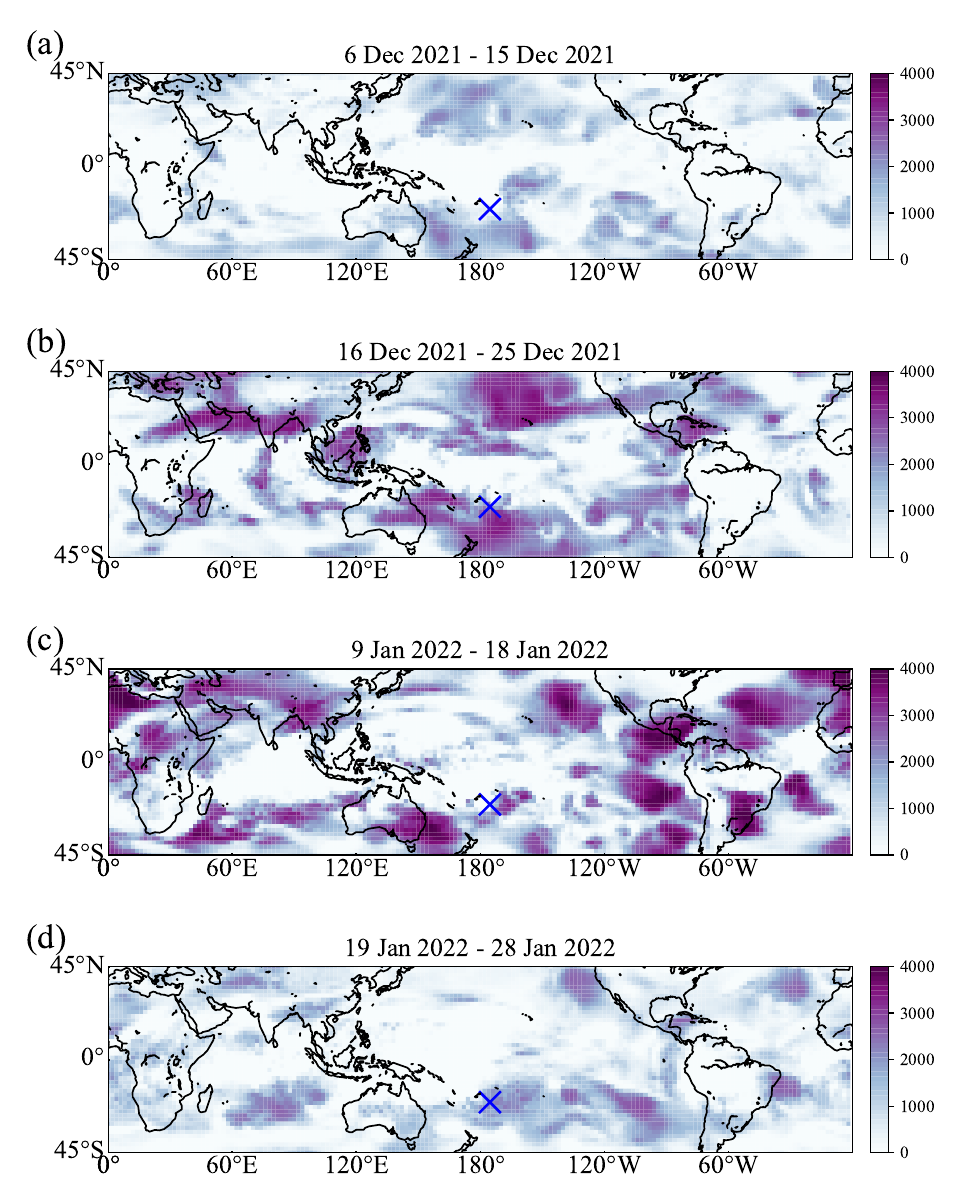
Figure 5. Network degree fields over the period ( a ) before the eruption, ( b ) the first dominant eruption, ( c ) the second dominant eruption, and ( d ) after the eruption of HTHH are presented. The corresponding periods are marked at the top of each subplot. The degree of nodes in the extratropics increases greatly during the eruption periods, which may be related to the impacts of volcanic eruption on global mass